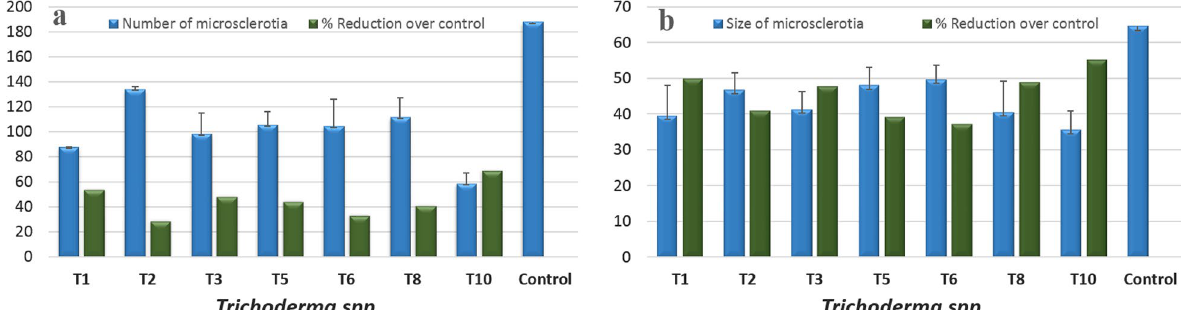
Fig. 4 Effect of Trichoderma isolate on number and size of microsclerotia of Macrophomina